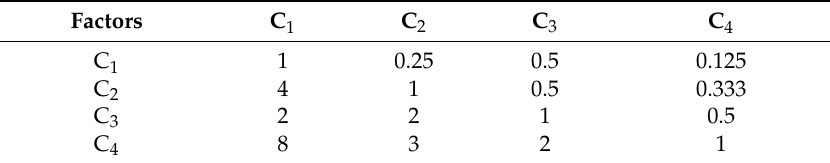
Table 2. Pair-wise comparison matrix of the factors (C1, C2, C3, and C4).